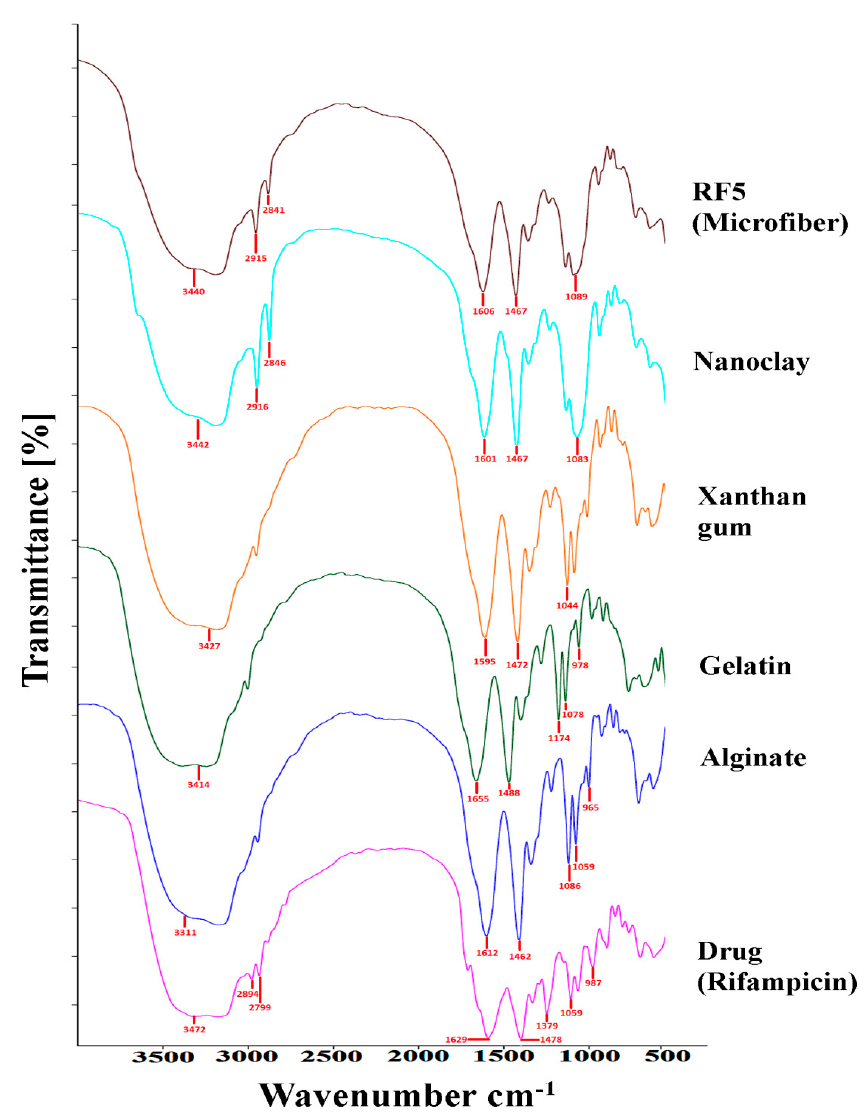
Figure 4. FTIR spectra of drug (rifampicin), alginate, gelatin, nanoclay and microfiber (RF5). Table 2. Various parameters of formulation batches.